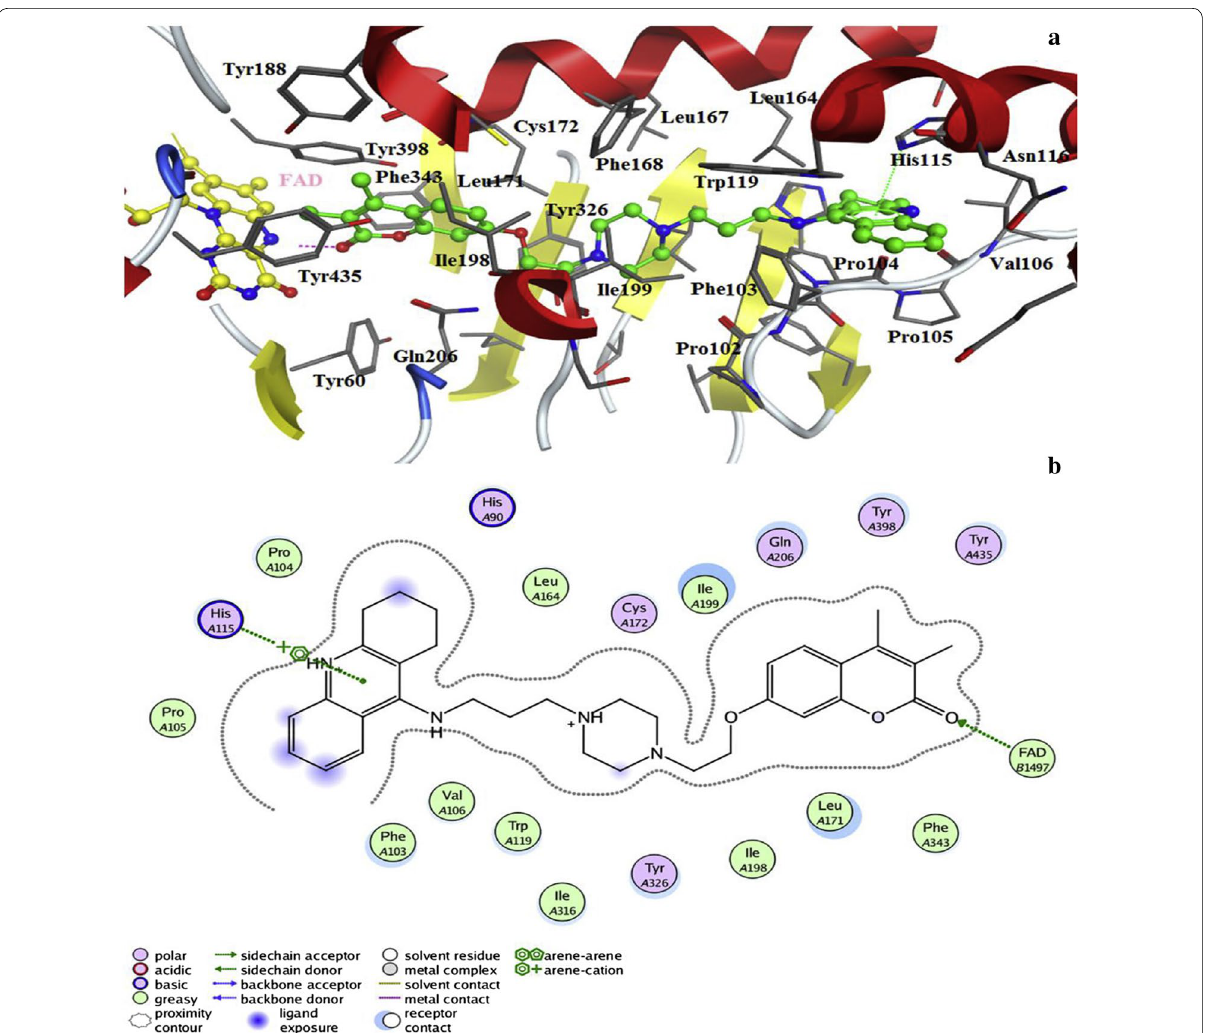
Fig. 86 ( a ) 3D docking model of compound C95 with MAO-B. b 2D schematic diagram of docking model of compound C95 with MAO-B